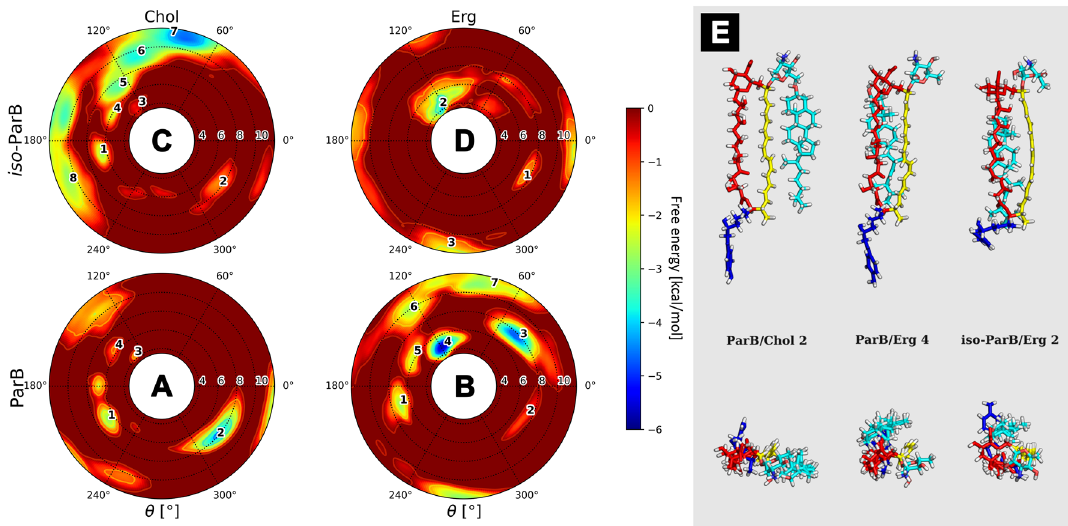
Figure 5. Free energy landscapes, calculated for partricin B (panels A & B ) and iso-partricin B (panels C & D ). Panel ( E ) contains representative structures of the (iso-)ParB/sterol complexes, extracted from selected energetic minima via cluster analysis. Number of a structure corresponds to the respective energetic minimum of a given system. Panel ( E ) colours: red—antibiotic’s polyol region; yellow—antibiotic’s heptaene chromophore; dark blue—alkyl-aromatic side chain; light blue—sterol